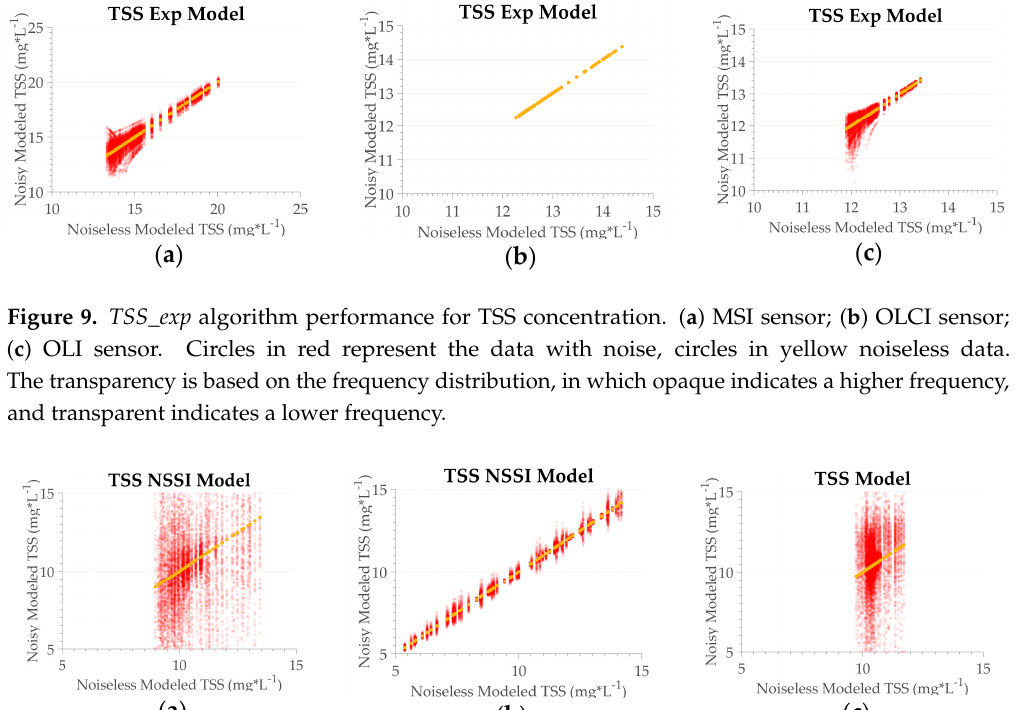
Figure 8. TSS_linear model performance for TSS concentration. ( a ) MSI sensor; ( b ) OLCI sensor; ( c ) OLI sensor. Circles in red represent the data with noise, circles in yellow noiseless data. The transparency is based on the frequency distribution, in which opaque indicates a higher frequency, and transparent indicates a lower frequency.